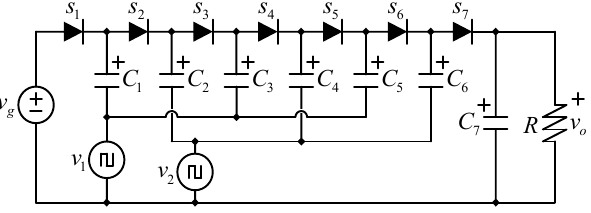
Figure 4. A multiple auxiliary input SC voltage multiplier [18].